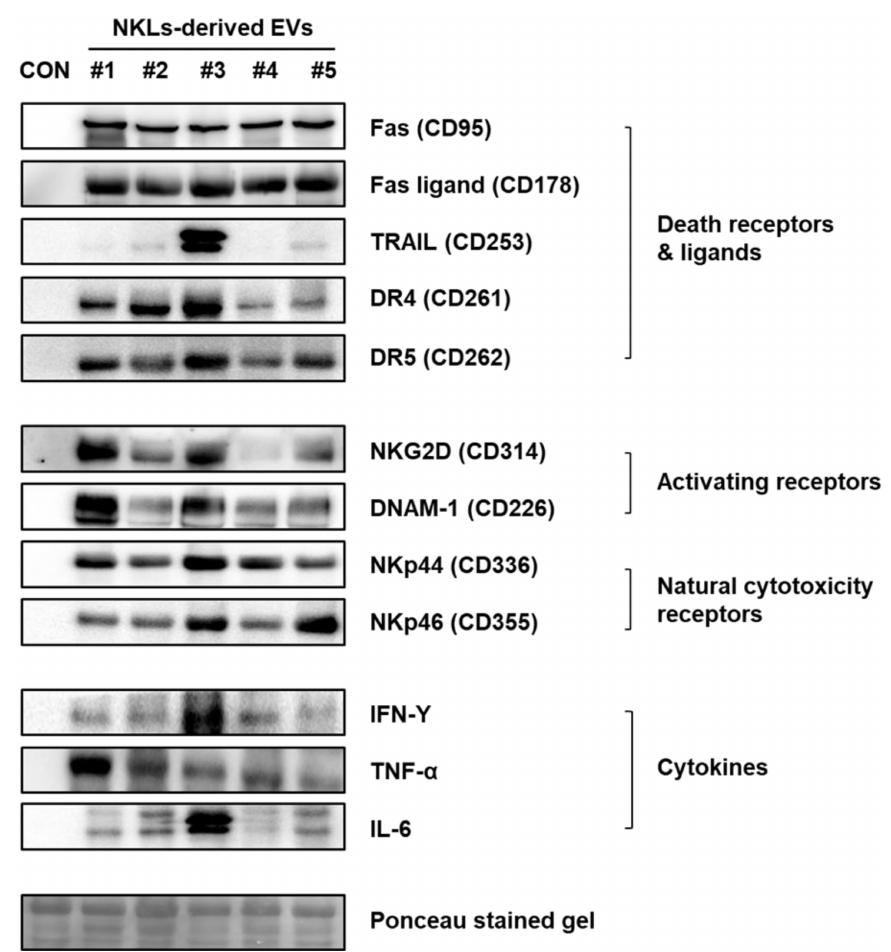
Figure 4. Expression of receptors, ligands, and cytokines related to cytotoxicity against cancer cells in NKL-derived EVs. CON: control